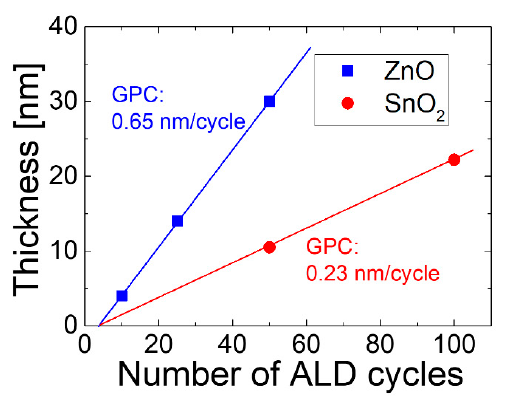
Figure 4. Variation in the thickness of ZnO and SnO 2 thin films grown on Si substrates as a function of the number of ALD cycles.